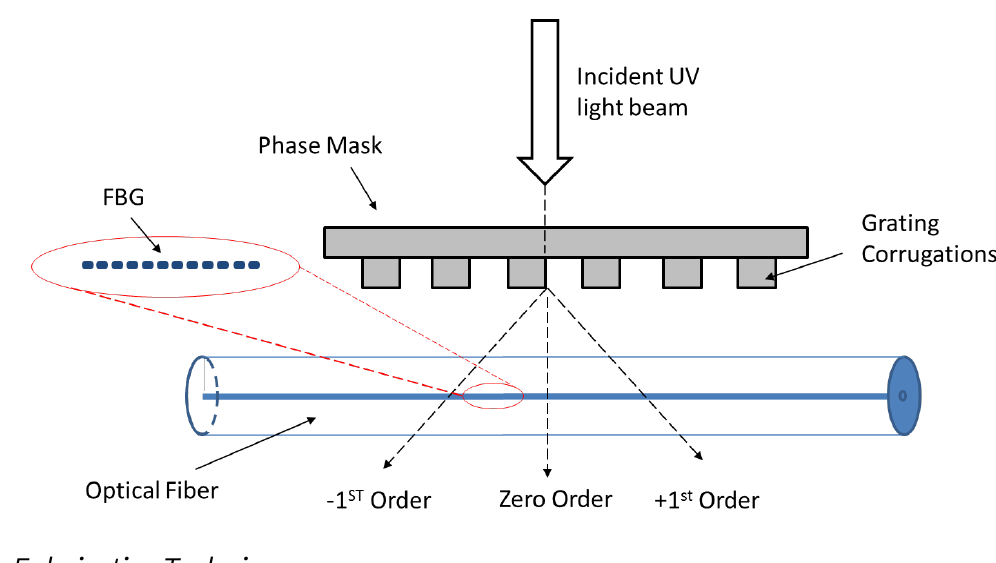
Figure 1. FBG fabrication process using Phase Mask